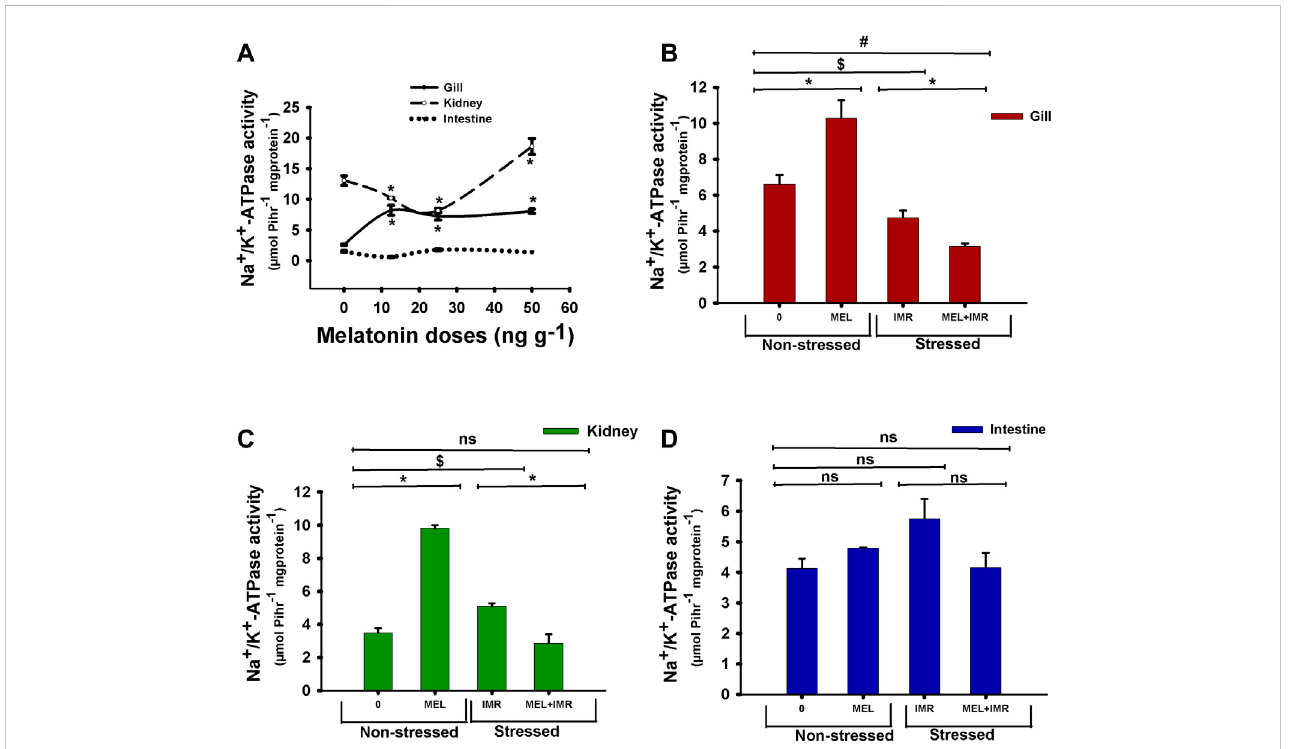
FIGURE 2 In vivo action of melatonin treatment on Na + /K + -ATPase (NKA) activity in gills, kidney and intestine of non-stressed or immersion-stressed air-breathing fi sh. Figure 2A shows dose-responsive action of melatonin (MEL; 12.5, 25 and 50 ng g − 1 ) and Figures 2B – D represent the action of melatonin (MEL; 50 ng g − 1 ) ontheactivitypatternofNKAingills (B) ,kidney (C) andintestine (D) innon-stressed orimmersion-stressed fi sh(Figures 2B – D).ForFigure2Athesigni fi cance, accepted at p < .05 level, are represented as “ * ” compared to control fi sh (0 ng g − 1 ). For Figures 2B – D “ * ” represent signi fi cance between non-stressed control(0)andmelatonin(MEL)treatedorcomparisonbetweenIMRandMEL+IMR fi sh. “ $ ” representssigni fi cancebetweennon-stressedcontrol(0)andIMR fi sh. “ # ” denotes signi fi cance between non-stressed control (0) and MEL + IMR fi